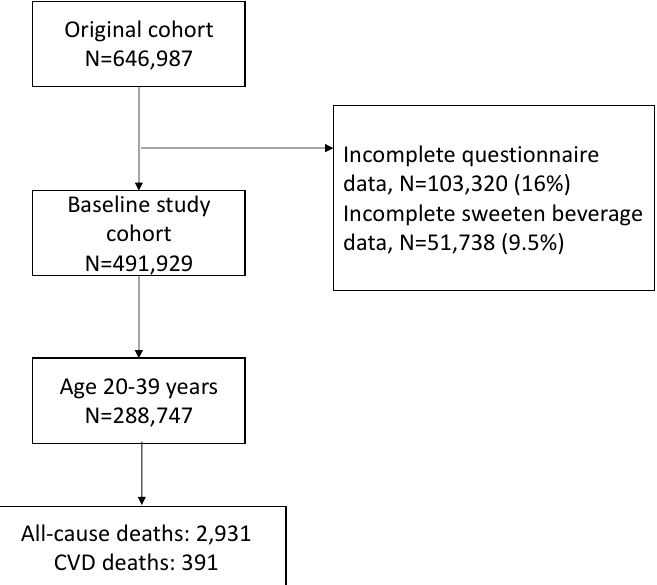
Figure 1. Flowchart of the enrolled participants.